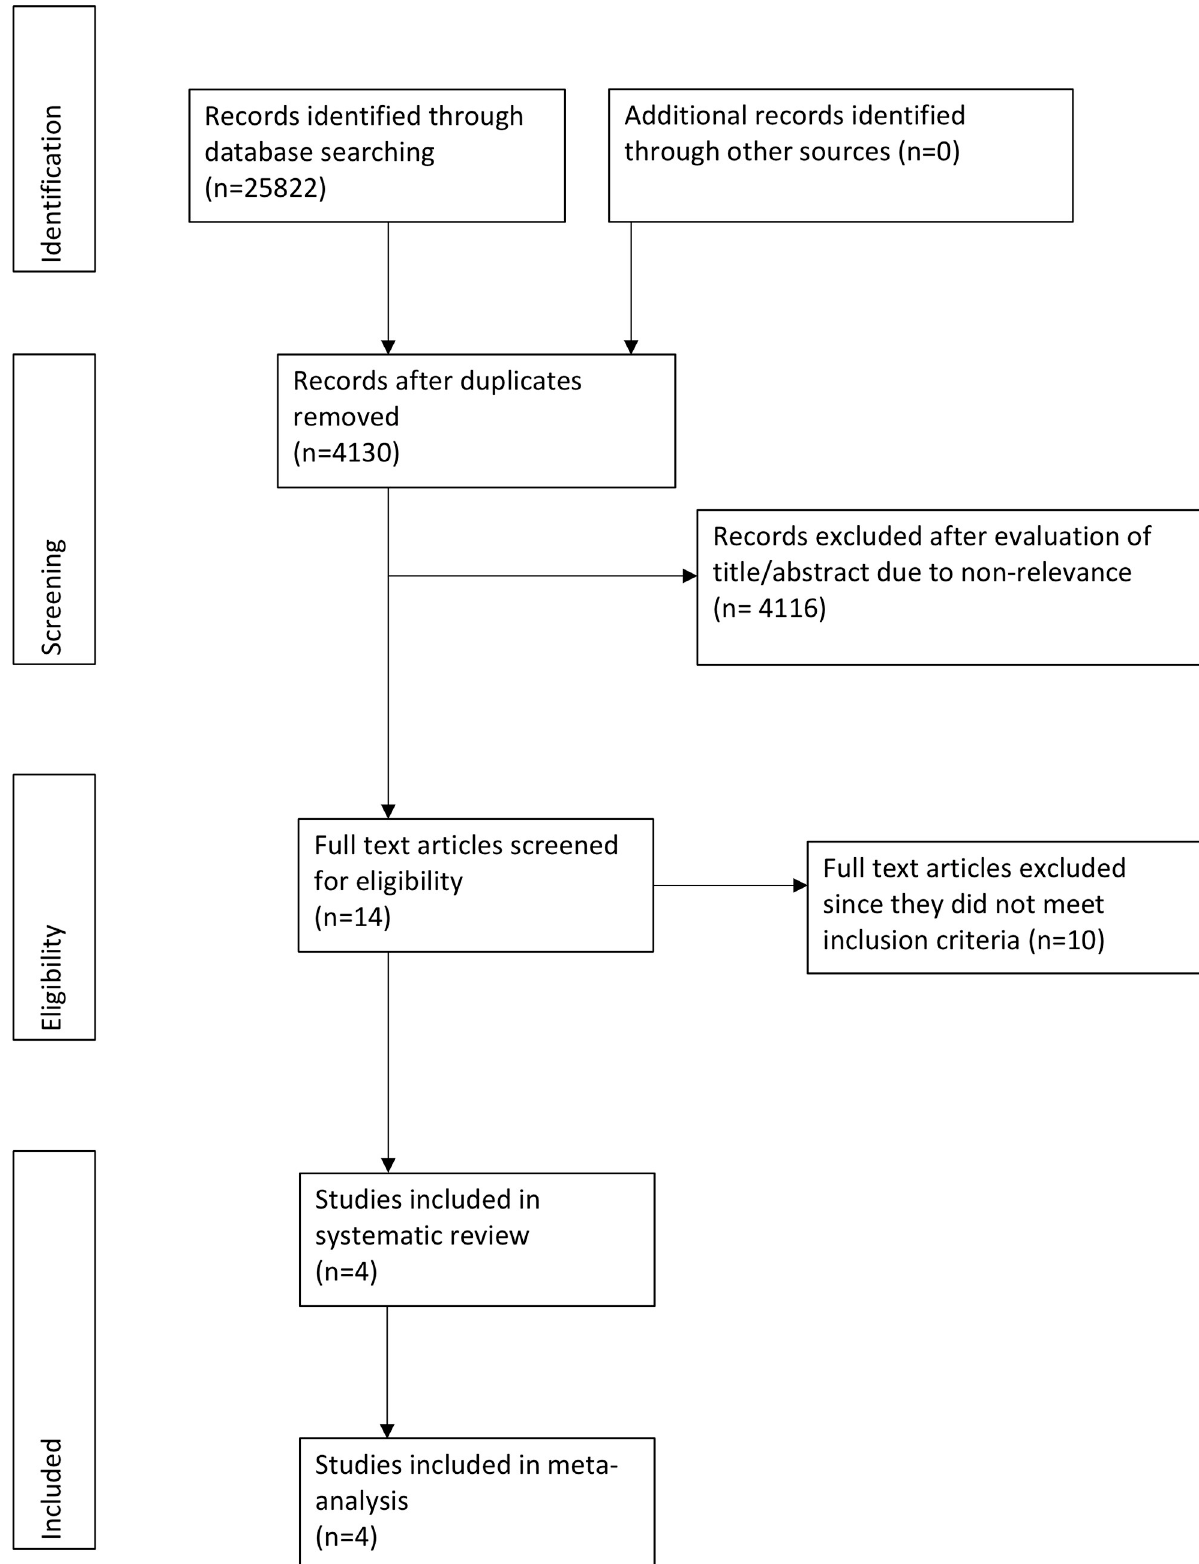
Fig 1. Flow diagram of the selection of studies and specific reasons for exclusion from the present meta-analysis.